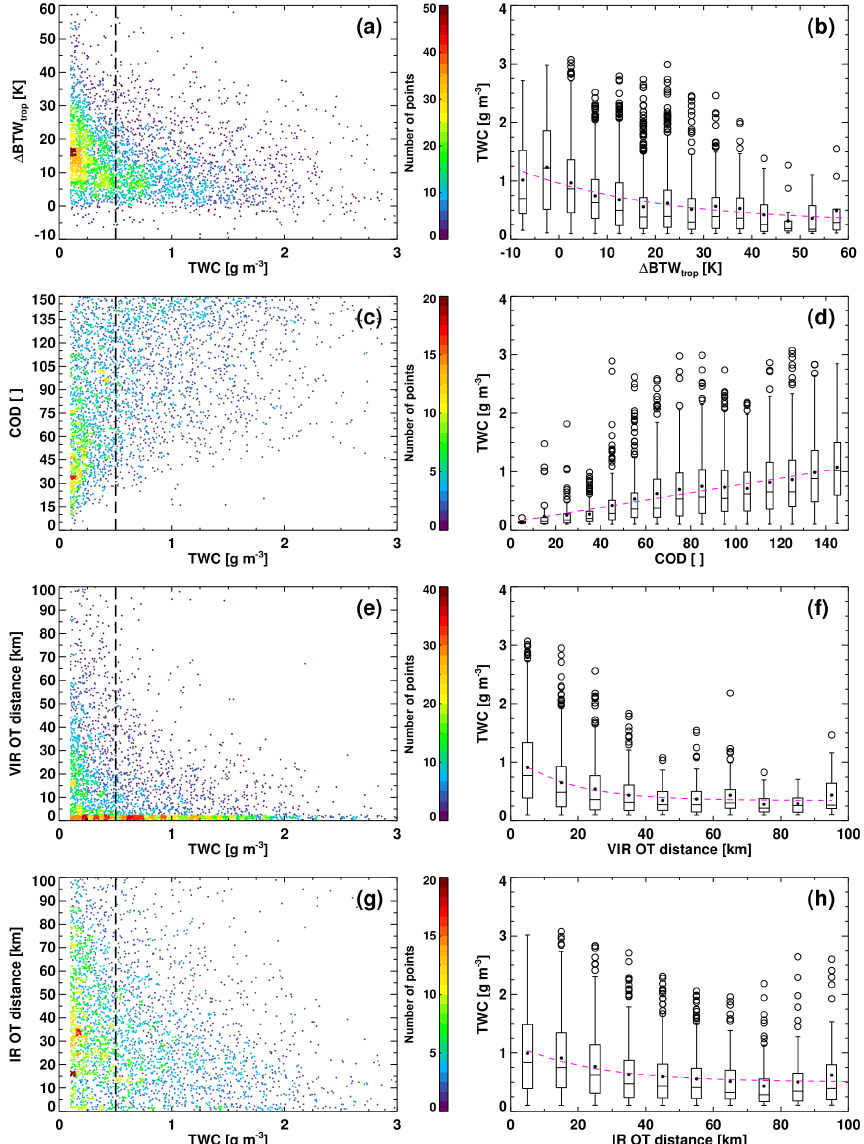
Figure 6. (a, c, e, g) The distribution satellite-derived parameter values as a function of 45s mean TWC using the training dataset based on 67% of the satellite–aircraft match database (3580 samples). The color represents the density of points in a given region of the scatterplot. The vertical dashed line shows the 0.5gm − 3 threshold where satellite parameters start to lose sensitivity to TWC. (b, d, f, h) The distribution of TWC as a function of satellite-derived parameters. (cid:49) BTW, COD, dOT VIS + IR, and dOT IR are shown from top to bottom. The magenta lines provide a fit to the mean of the distributions and serve as PHIWC fuzzy logic membership